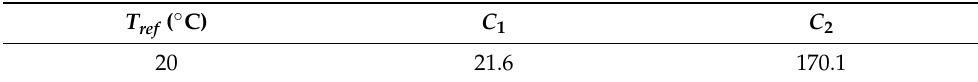
Table 3. WLF parameters of the asphalt layer.